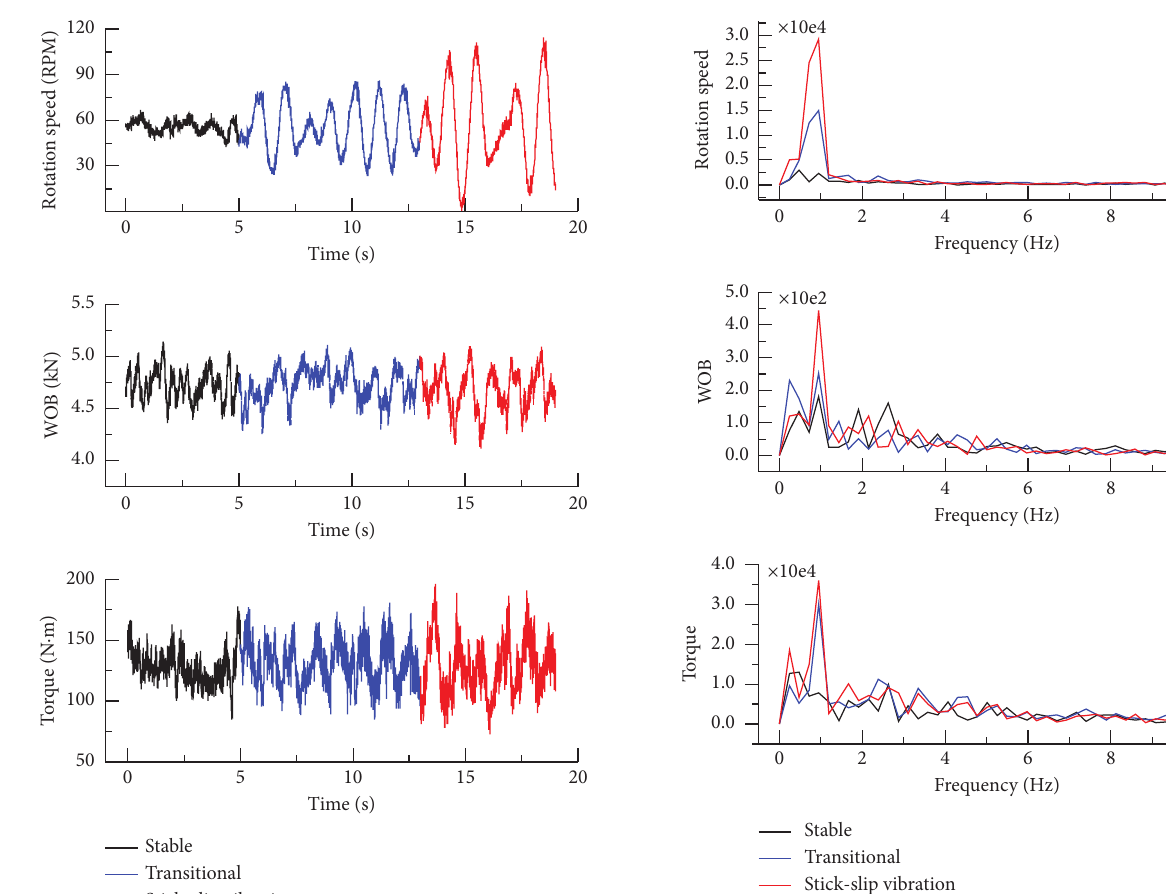
Figure 3: Process of stick-slip vibration generation and